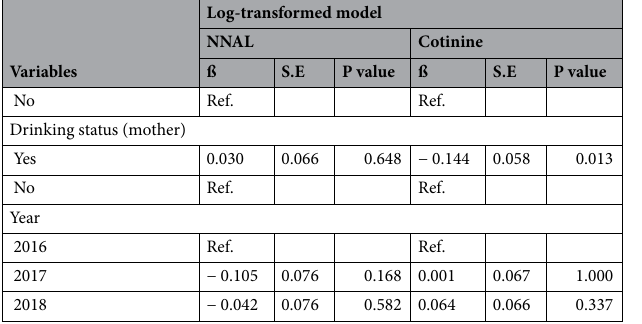
Table 2. Association between the concentrations of urinary NNAL and cotinine in children and parents’ smoking status. BMI body mass index, NNAL 4-(methylnitrosamino)-1-(3-pyridyl)-1-butanol, Ref. reference